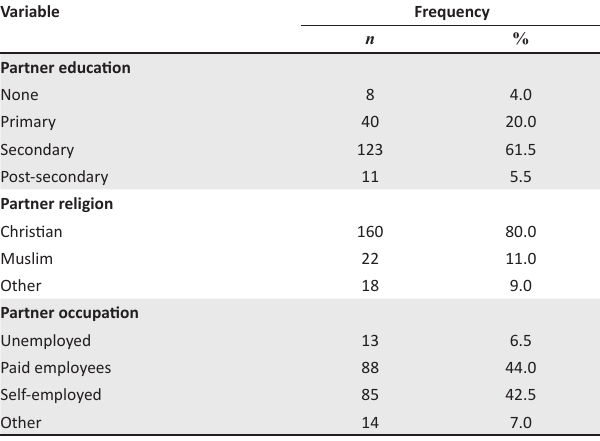
TABLE 2: Characteristics of the partners to the participants.